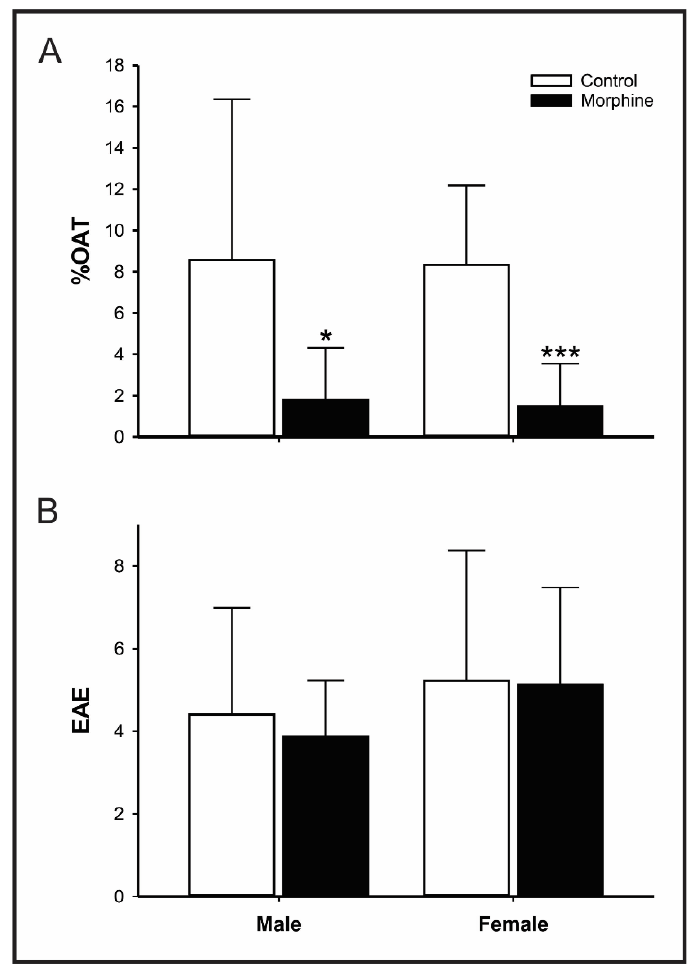
Figure 4. Effect of morphine treatment (10 mg/kg/day) during pregnancy and lactation on rat offspring ( A ) percentage of time in open arms; and ( B ) number of entries in the enclosed arms (EAE) in Elevated Plus Maze test. Results expressed as mean ± S.D.M. (male control = 10; female control = 10; male morphine = 8; female morphine = 10). * p < 0.05 morphine vs. respective control group. *** p < 0.001 morphine vs. respective control group. Student’s t ‐ test.